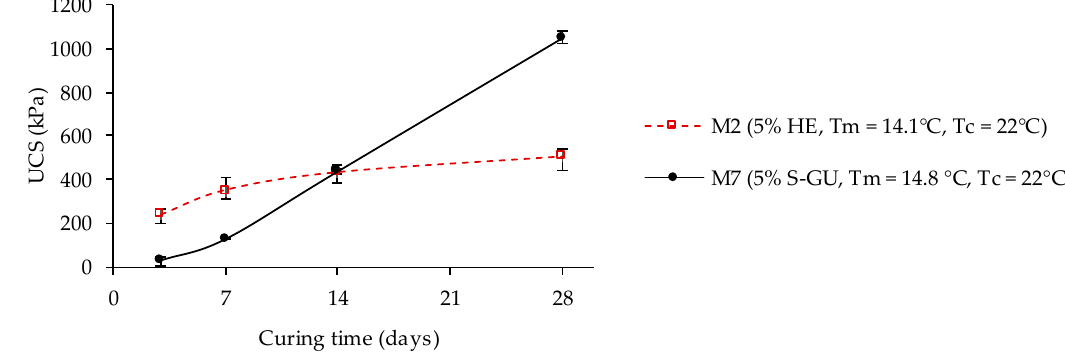
Figure 4. Comparison of the UCS of CPB samples containing 5% HE (M2) and S-GU (M7) with temperature at the end of mixing at 14 °C and at constant curing temperature (22 °C) in the humidity chamber.